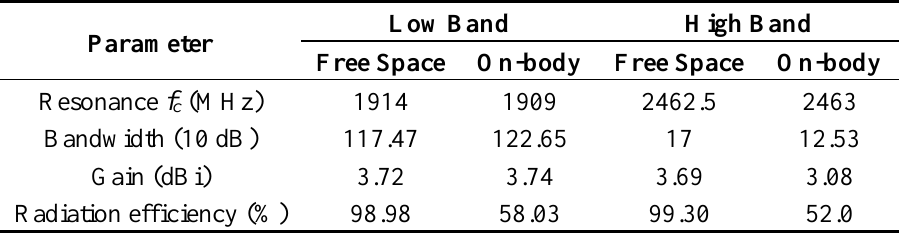
Table 2. Simulated free space and on-body performance parameters of the PIFA.